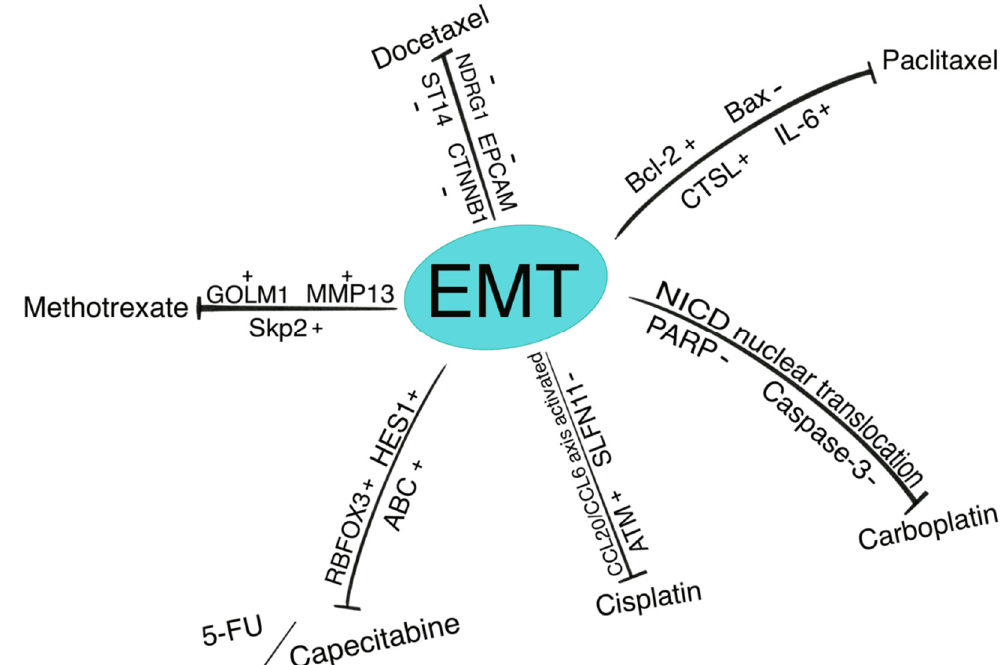
Figure 3. Variation of intra/extracellular factors during the EMT process. These expression changes underlie chemothera- peutic drug resistance. +: up-regulation, -: